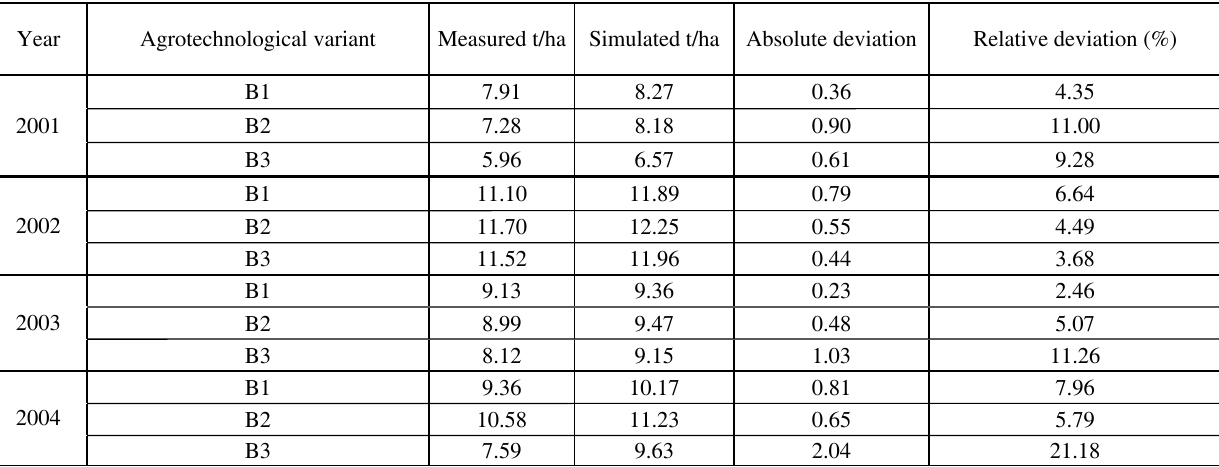
Table 2 . Grain yields and deviations